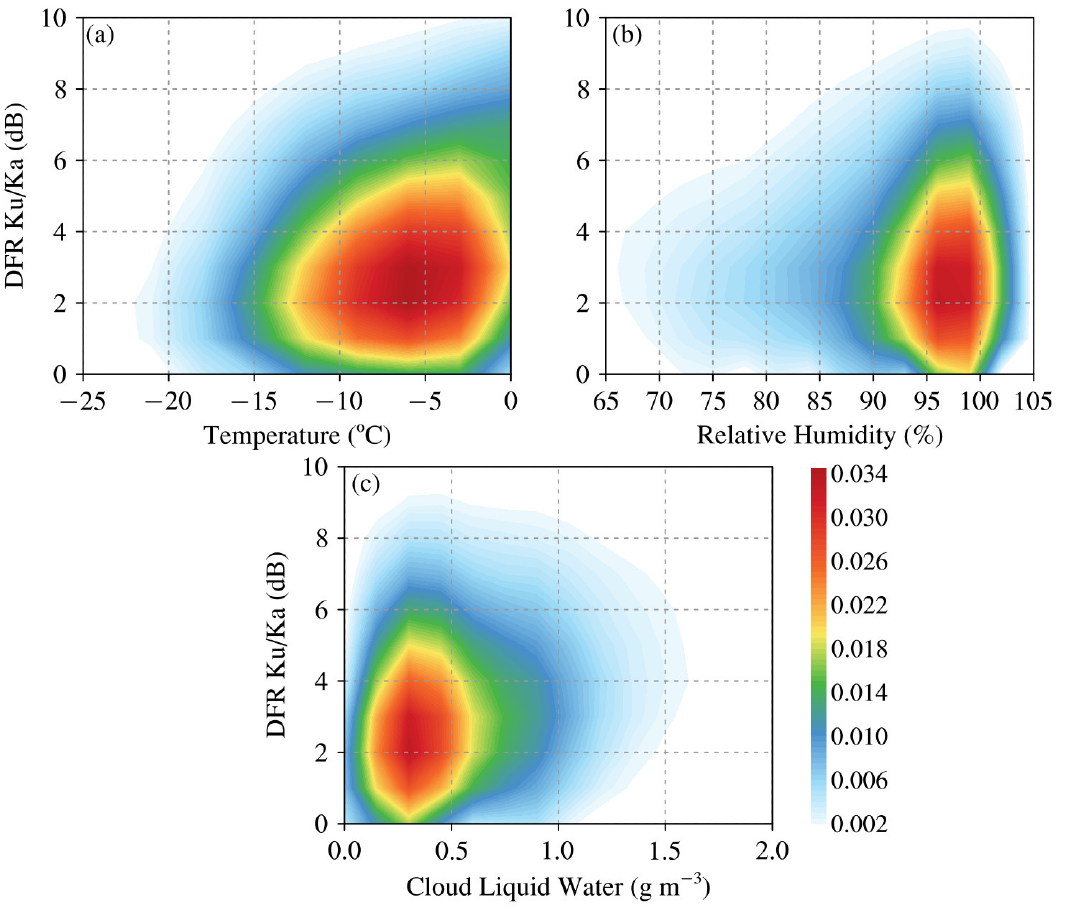
Figure 5. Dependence of DFR Ku/Ka on ( a ) temperature, ( b ) relative humidity and ( c ) cloud liquid water. Shading represents the normalized occurrence frequencies.